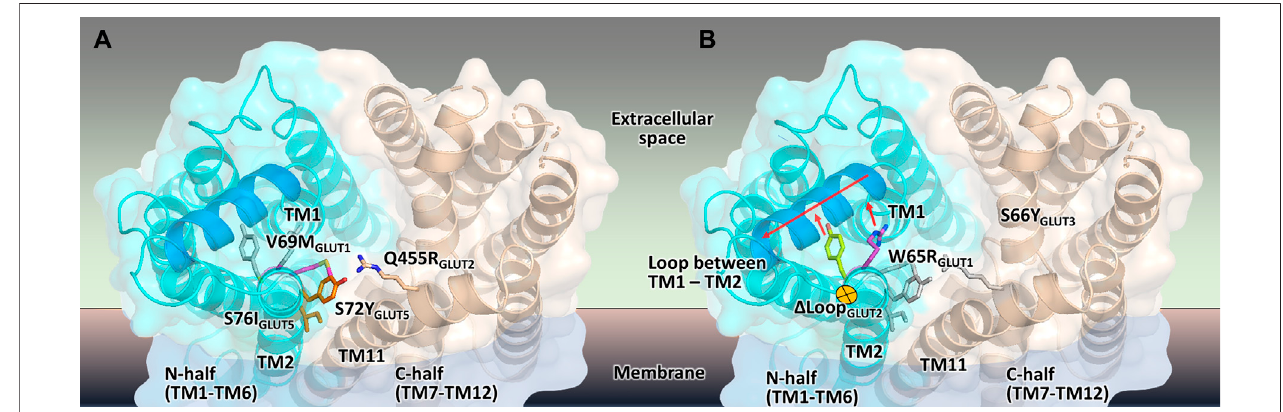
FIGURE 7 | Mapping the mutations that render different GLUTs active in hxt 0 yeast cells. (A,B) The structural model ofthe outward-facing conformation for GLUT1-3 and GLUT5 showing the single-site mutations that provide or increase transport activity of the respective human GLUT upon expression in hxt 0 yeast cells, viewed from the extracellularside.The mutants aregenerallysubstitutionstobulkier sidechains and fallinto twocategories. (A) Mutants thatdisruptthe packing between theN- and C-domains (colored as cyan and wheat, respectively), such as S72I and S76Y of GLUT5, Q455R of GLUT2, and V69M of GLUT1. (B) Mutants that dislocate the loop between TM helices TM1 and TM2 (the part of the loop that needs to move to accommodate the mutations is shown in blue), causing it to move away from the central cavity, such as S66Y of GLUT3 and W65R of